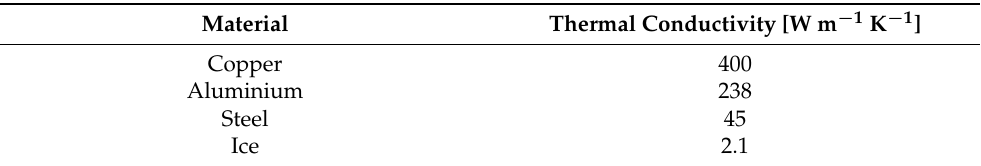
Table 1. The thermal conductivity at 300 K for the three substrate materials. The conductivity of ice at 269 K is also included for